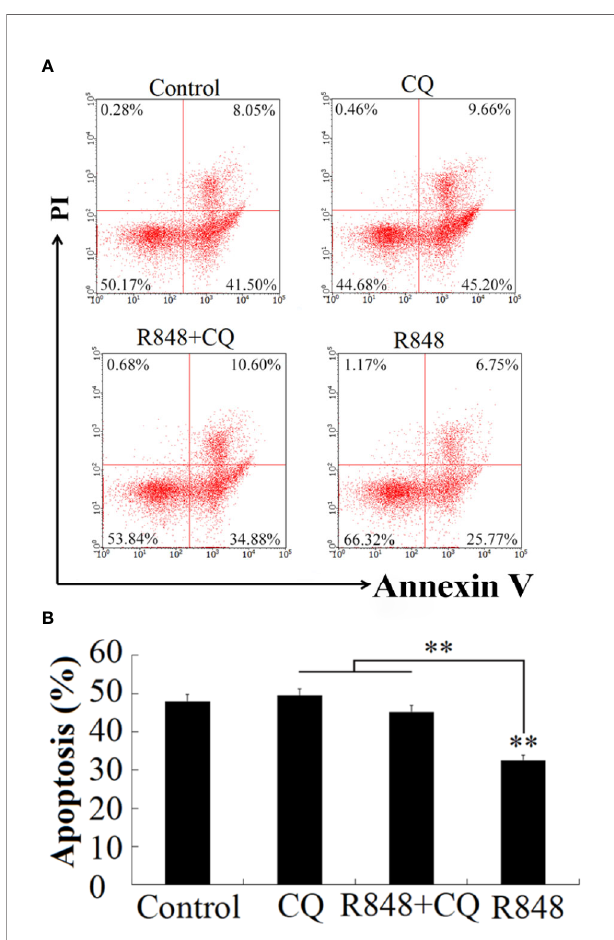
FIGURE 3 | Effect of R848 and chloroquine (CQ) on the apoptosis of HKLs. (A) Golden pompano HKLs treated with or without (control) 8 µg/ml R848, 5 µg/ml CQ, or 8 µg/ml R848 plus 5 µg/ml CQ, and then the apoptosis rates of these cells were determined by the fl ow cytometry. (B) The percentages of apoptotic cells are represented with statistic bar charts. Data are presented as means ± SD (N = 3). N, the number of times the experiment was performed. **P <